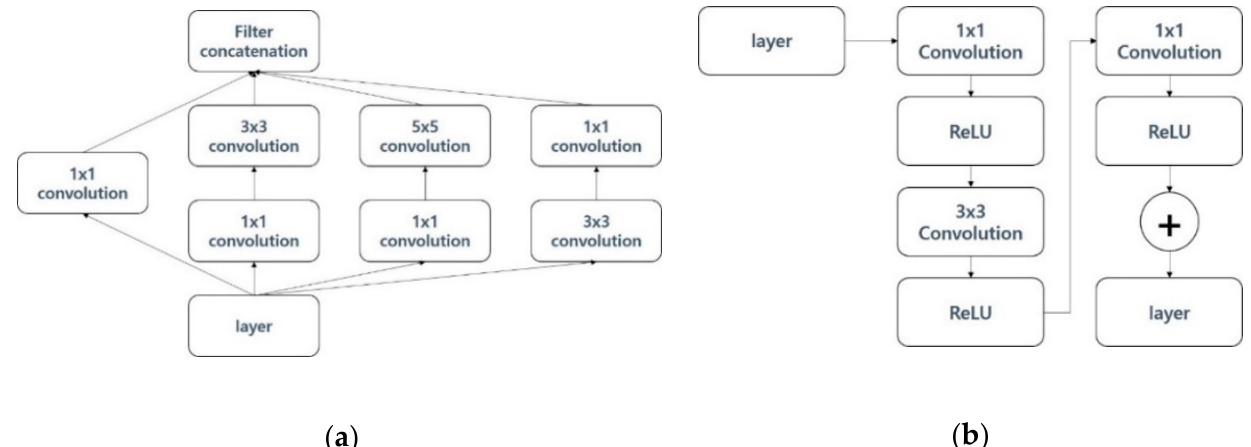
Figure 3. ( a ) Inception v3 model; ( b ) ResNet v2 model.